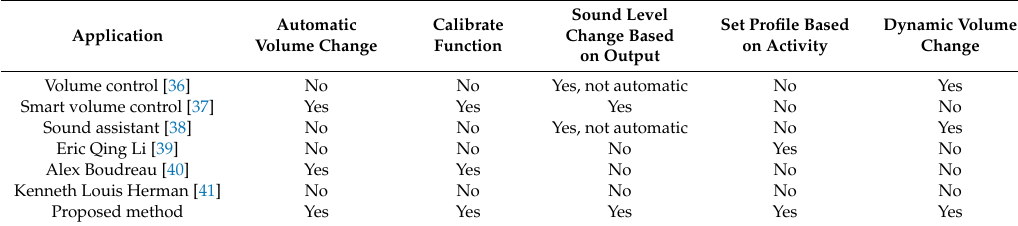
Figure 11. Test case three-axis outputs for various activities.